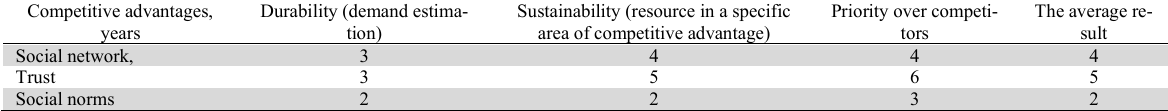
Assessing the sustainability of competitive advantages Competitive advantages, Durability (demand estima- Sustainability (resource in a specific years tion) area of competitive advantage)